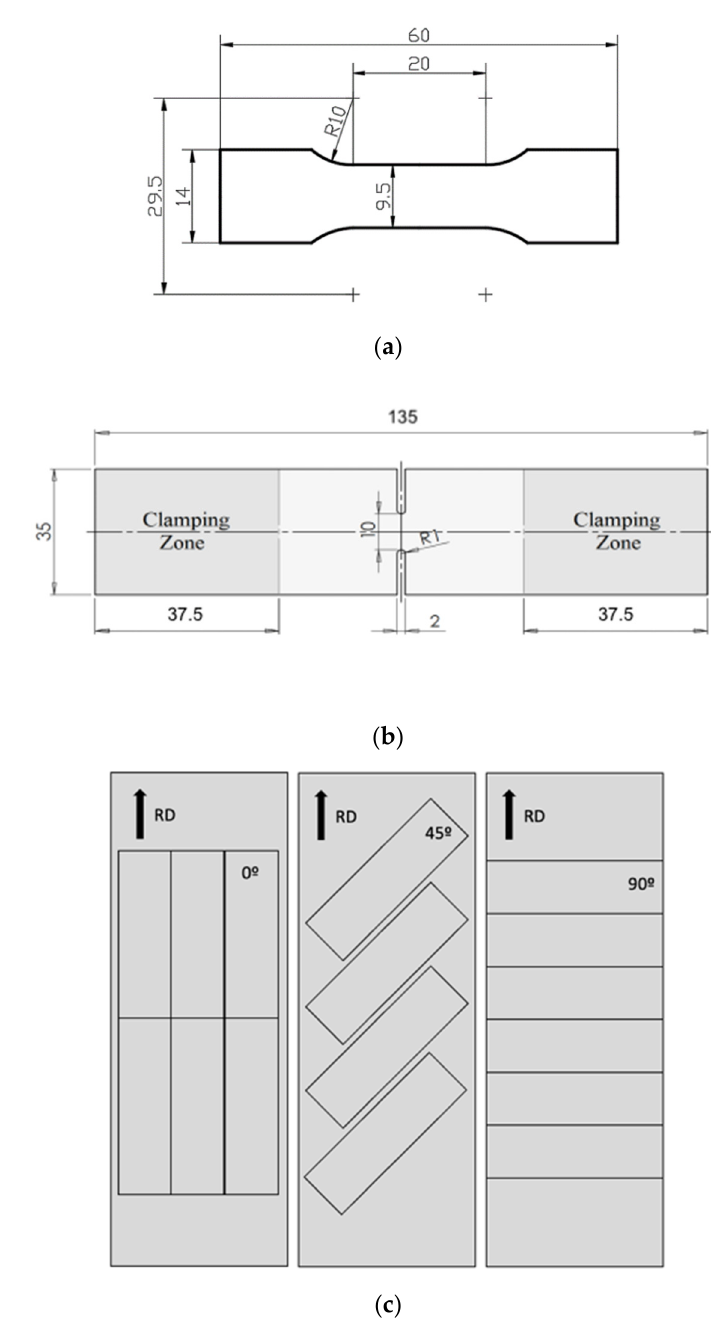
Figure 4. Specimen dimensions: ( a ) tensile test specimen; ( b ) plane strain specimen; ( c ) position of tensile test specimens on the rolled sheet.